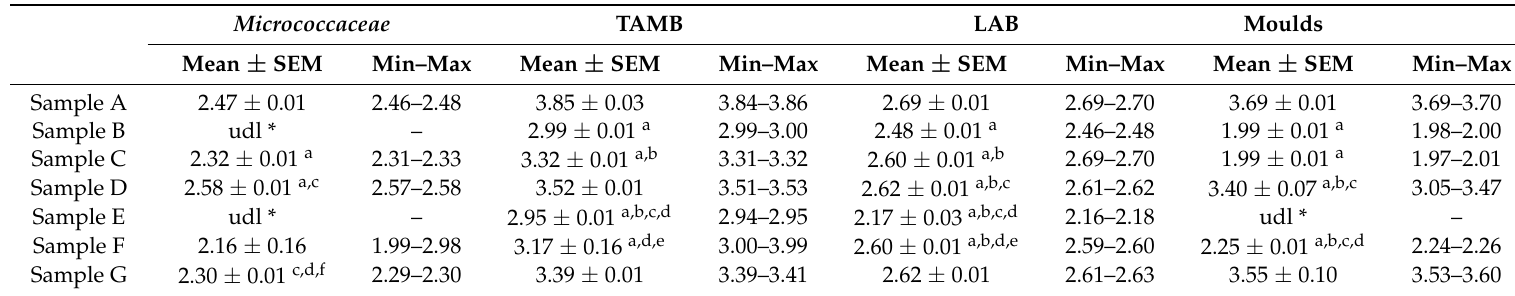
Table 4. Microbiological analysis results (log CFU/g).